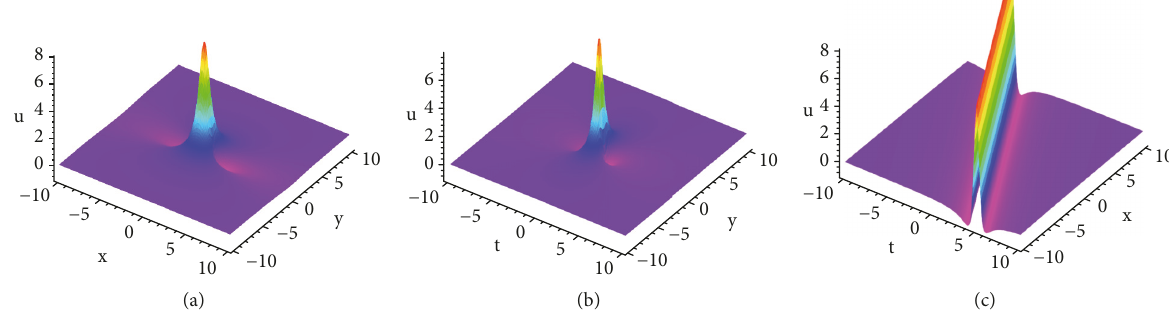
Figure 1: Plots (colored online) of rogue wave 𝑢 1 with 𝑚 = 2, 𝑎 = 𝑏 = −2 . (a) Perspective view of the wave 𝑢(𝑥, 𝑦,0) , (b) perspective view of the wave 𝑢(0, 𝑦, 𝑡) , and (c) perspective view of the wave 𝑢(𝑥, 0,𝑡) .